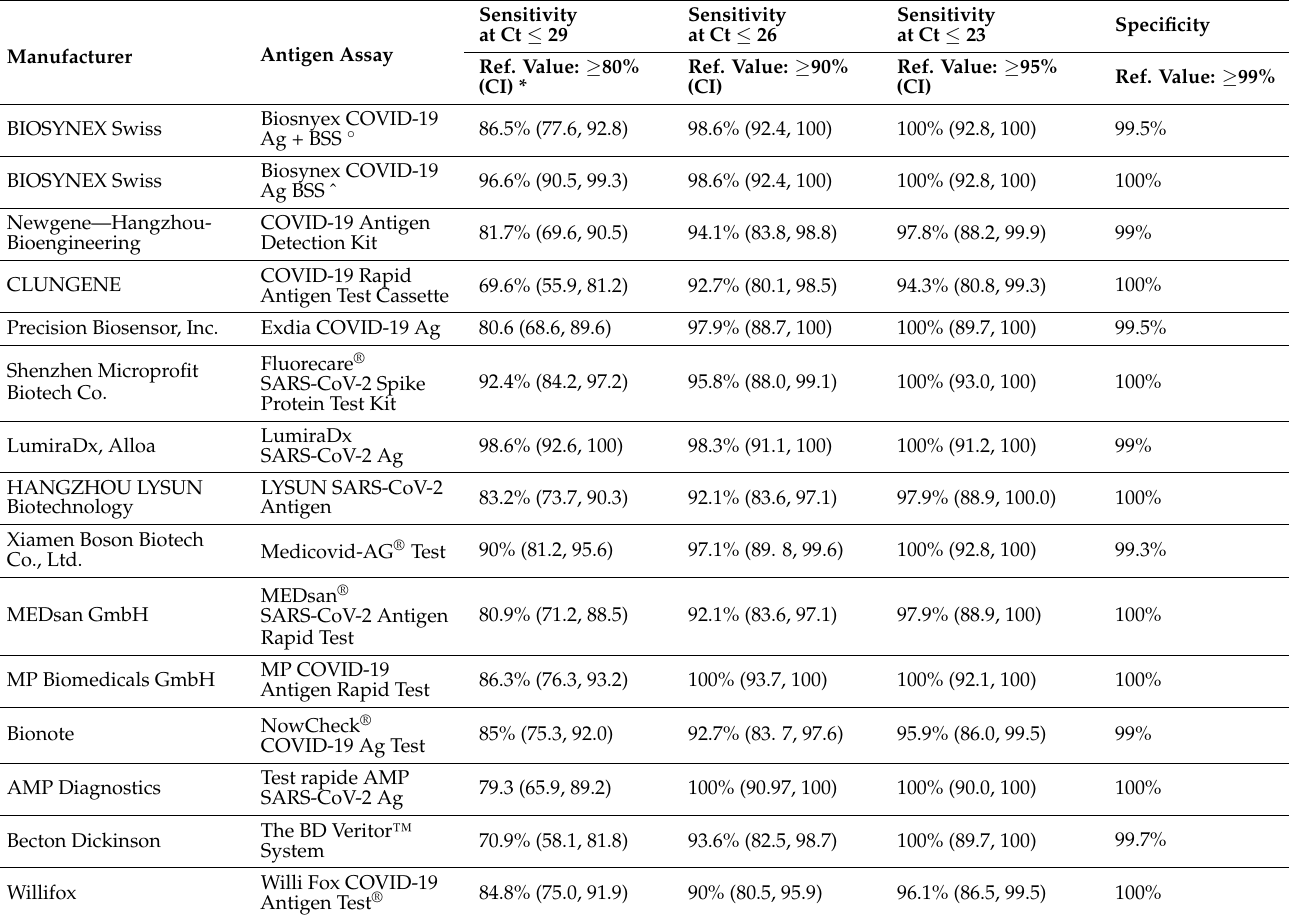
Table 1. Sensitivity and specificity rates of antigen tests passing the validation, stratified according to the viral load. Numbers in brackets indicate the 95% confidence